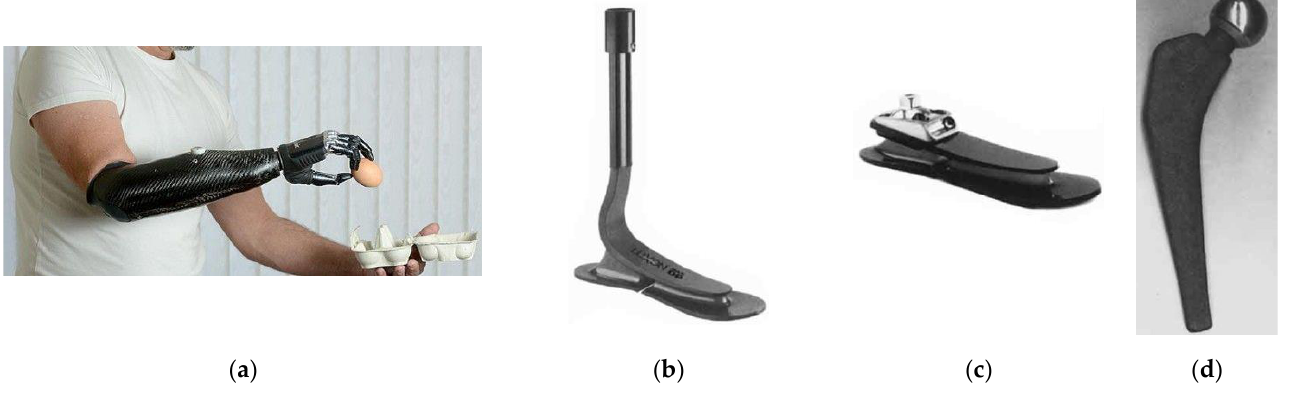
Figure 19. ( a ) Carbon composite mechanical hand [62], ( b ) carbon/epoxy composite leg prosthesis, Figure 19. (a) Carbon composite mechanical hand [62], (b) carbon/epoxy composite leg prosthesis, (c) carbon/epoxy foot prosthesis, and (d) carbon/polysulfone hip prosthesis [1] (adapted with ( c ) carbon/epoxy foot prosthesis, and ( d ) carbon/polysulfone hip prosthesis [1] (adapted with permission from Refs. [1,62]). permission from Refs.